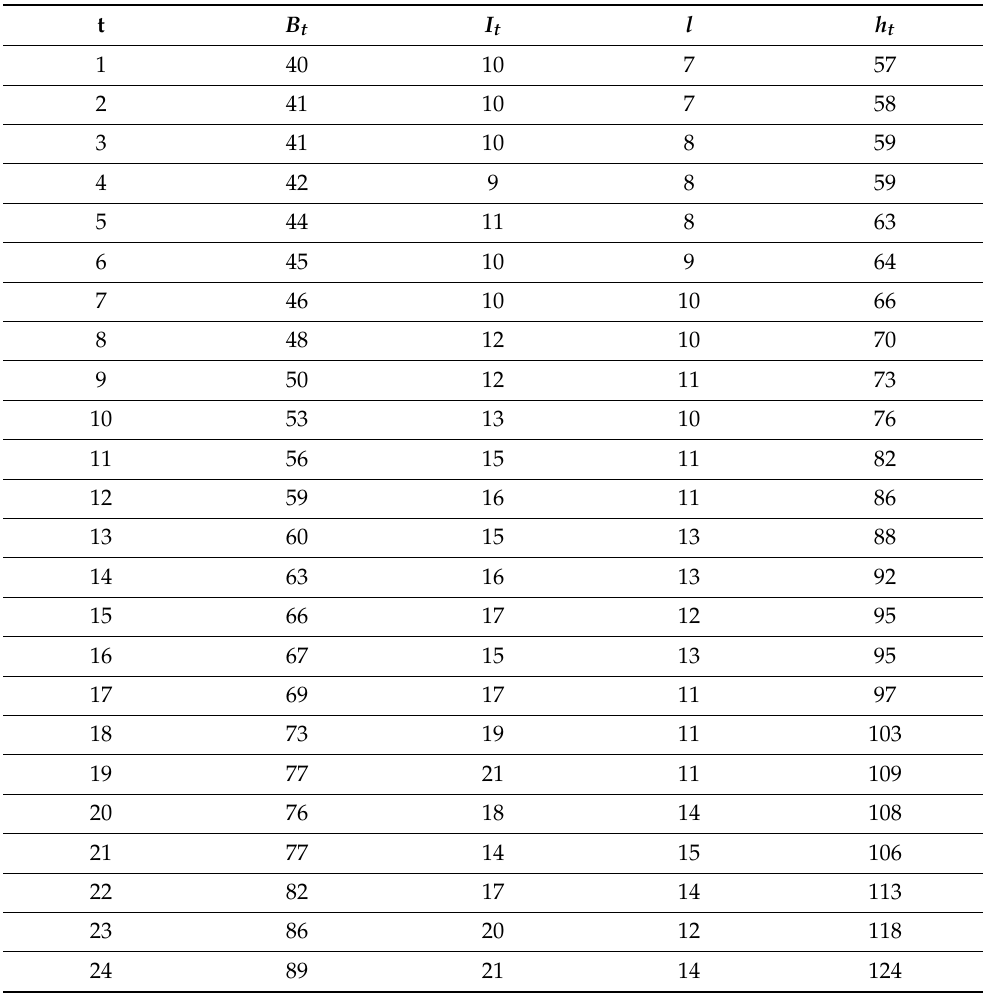
Table A1. The source information for the model of investment project assessment in the system of indicators of risk-efficiency (retrospective